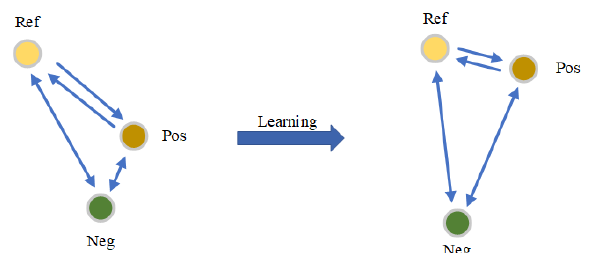
Figure 2. The improved triplet loss resembles the image features of same location, making the image features of different location tend to be different For feature extraction networks, different deep convolutional neural networks can be used. Considering on-board performance limitations, this paper used a lightweight deep convolutional network MobileNetV2 (Sandler et al., 2018) with Inverted Residuals and Depthwise Separable Convolutions